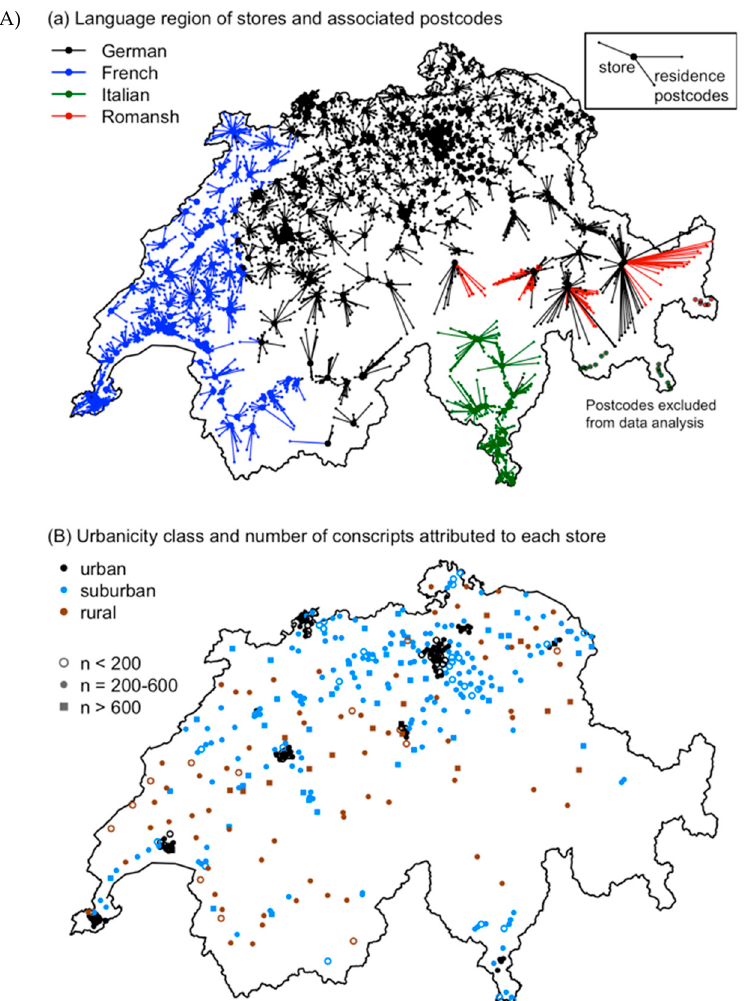
Figure 1. Distribution of stores (points) ( A ) with lines indicating the postcodes of residence attributed to each store based on spatial proximity and colors showing language regions and ( B ) with urbanicity class and the number of young men with BMI data (Swiss Army conscripts) attributed to each store.